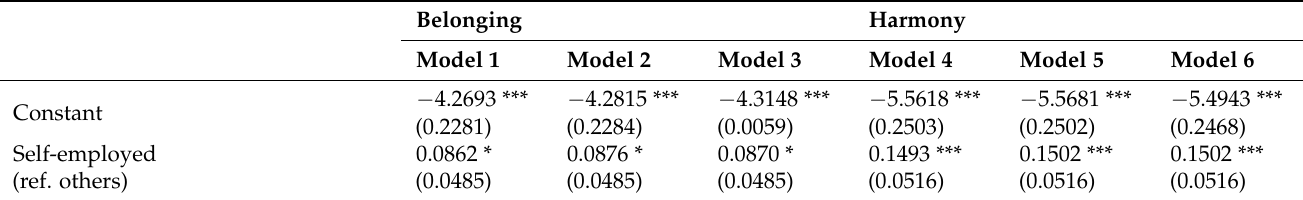
Table 4. Results of moderate effect